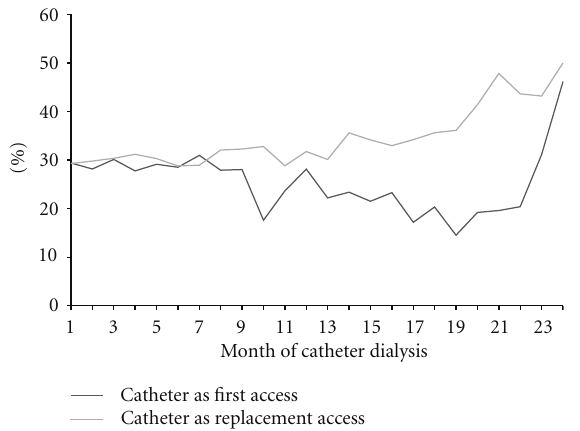
Figure 4: Percent of patients with catheter dysfunction. Catheter dysfunction was defined as unplanned blood flow rate during the dialysis session of < 300mL/min.